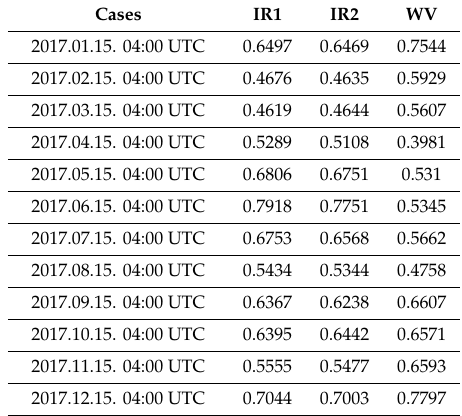
Table 3. Daytime correlation coe ffi cients among the COMS MWIR, WV, IR1, and IR2 bands. Cases IR1